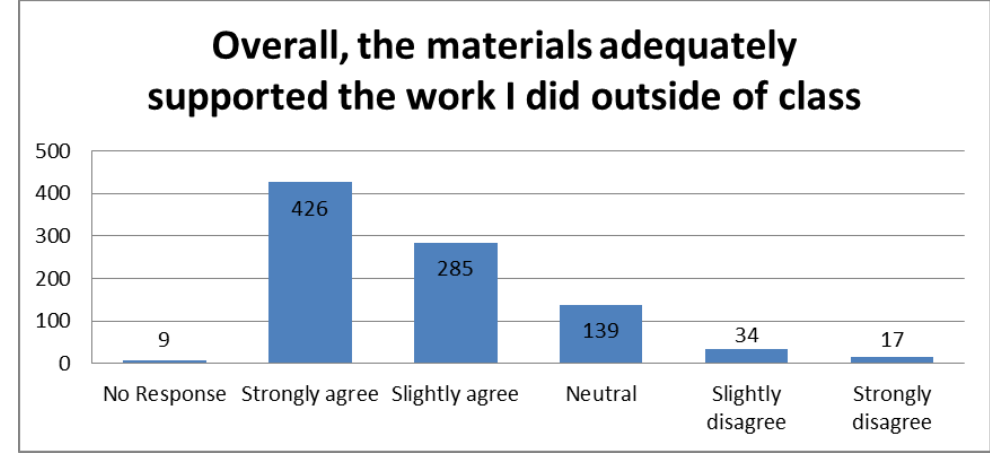
Figure 2 . Student responses to the statement, “Overall, the materials adequately supported the work I did outside of